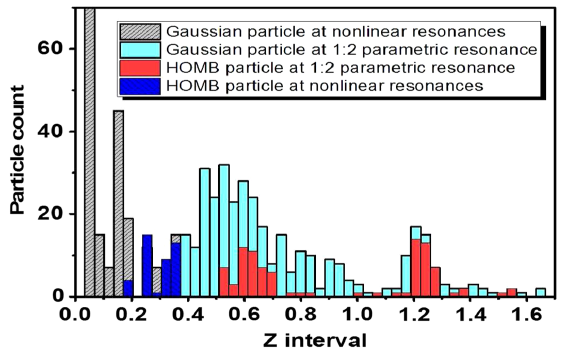
FIG. 12. Histogram of particle loss as a function of distance down the RFQ, for the Gaussian and HOMB, for a mismatch of